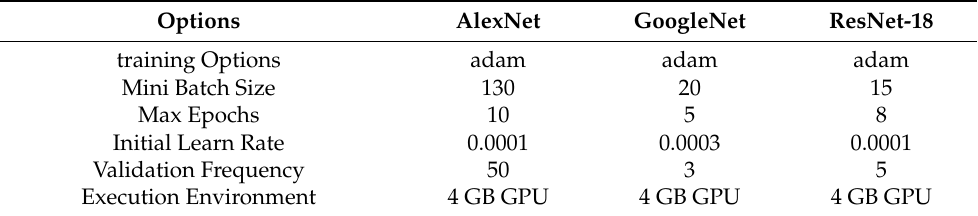
Table 4. Adjust training parameters options for AlexNet, GoogLeNet and ResNet-18 models. Options